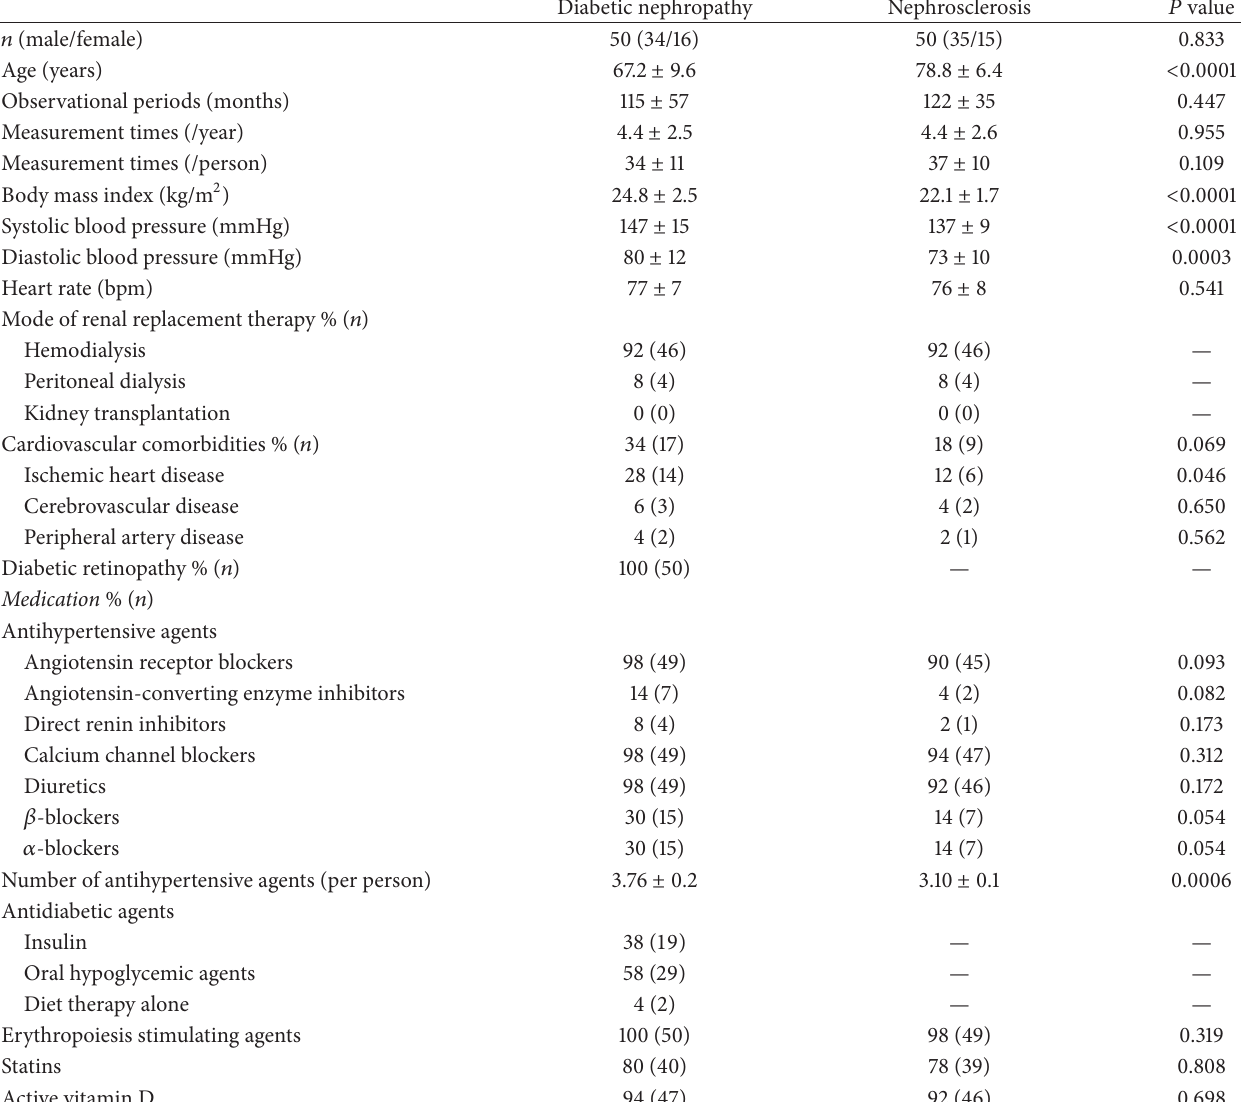
Table 2: Clinical characteristics and medications at the initiation of RRT in the two groups. Diabetic